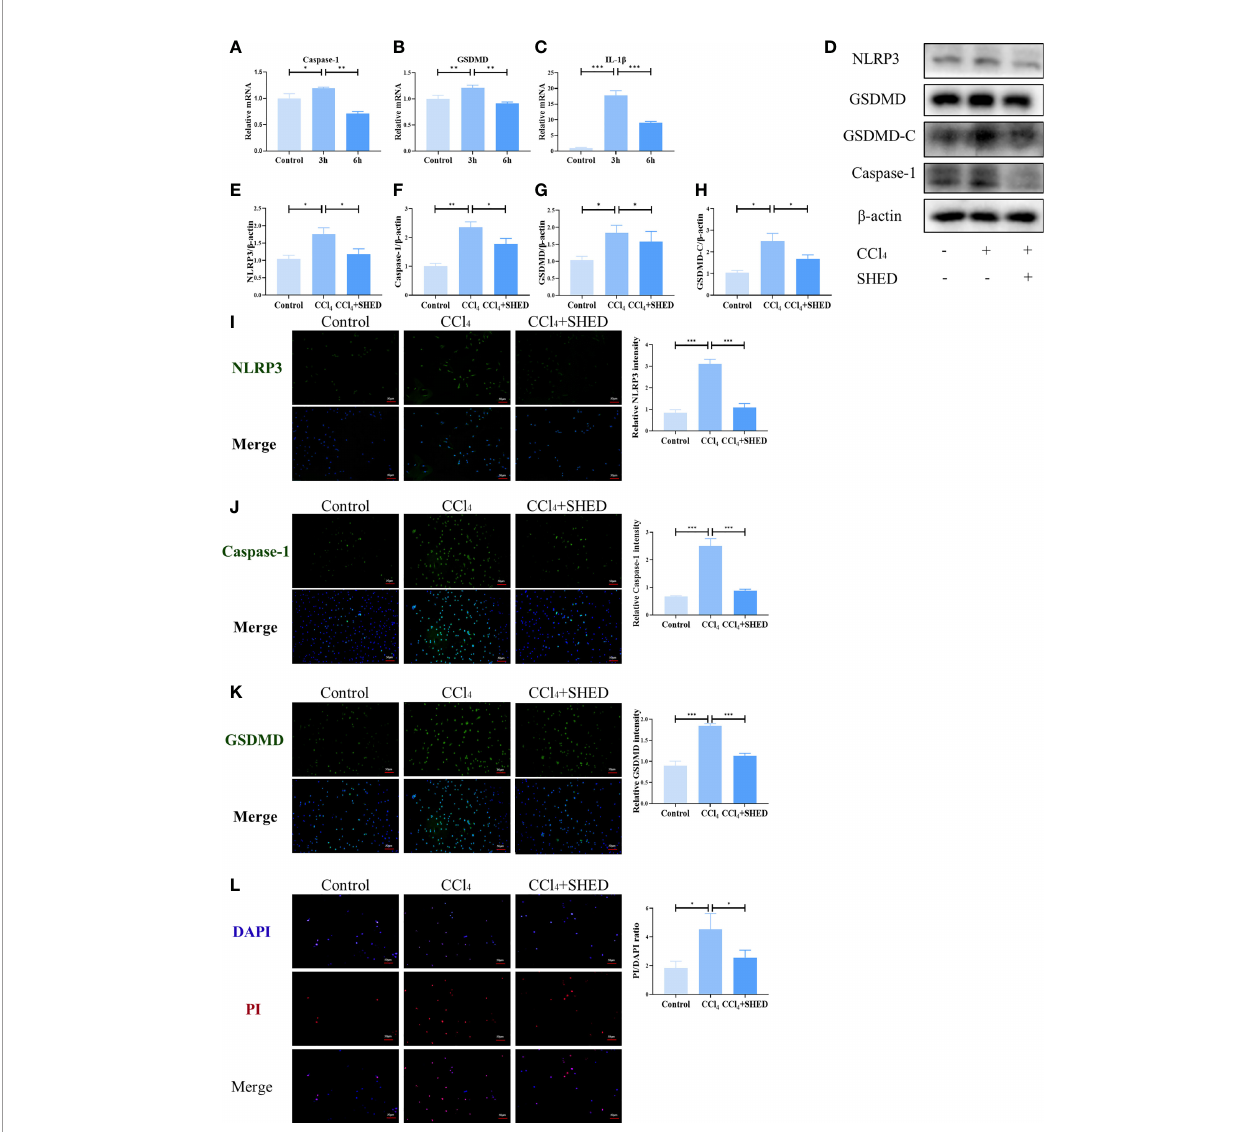
FIGURE 3 | SHED inhibited CCl 4 -induced NLRP3 in fl ammasome activation and pyroptosis in hepatocytes. (A – C) The mRNA level of Caspase-1, GSDMD, and IL-1b was detected after 3h and 6h CCl 4 stimulation analyzed by RT-qPCR. (D – H) The expression levels of NLRP3, Caspase-1, and GSDMD-C in hepatocytes in control, CCl 4 , and SHED infusion group by Western blotting analysis. (I – K) THe expression of NLRP3, Caspase-1 and GSDMD in hepatocytes in control, CCl 4 , and CCl 4 +SHED groups was analyzed by immuno fl uorescence staining. (L) The ratio of dead cells was determined by PI staining in control, CCl 4 , and CCl 4 +SHED groups. Scale bar: 50 m m. *p < 0.05, **p < 0.01, and ***p < 0.001. Graph bars show the mean ± SD. All of the assays were performed in triplicate. PI, propidium iodide; SHED, stem cells from human exfoliated deciduous teeth; GSDMD, gasdermin